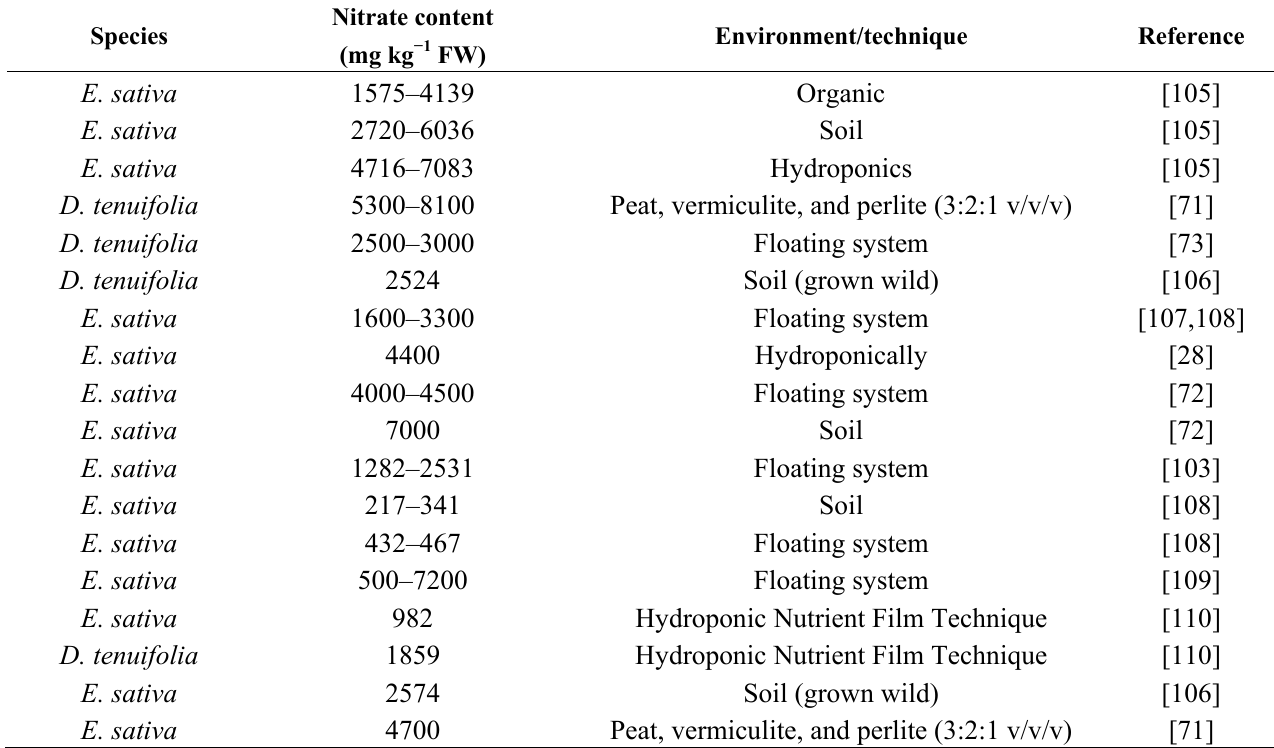
Table 3. Nitrate content in the leaves of rocket species grown in different environment or cultivation in different agricultural